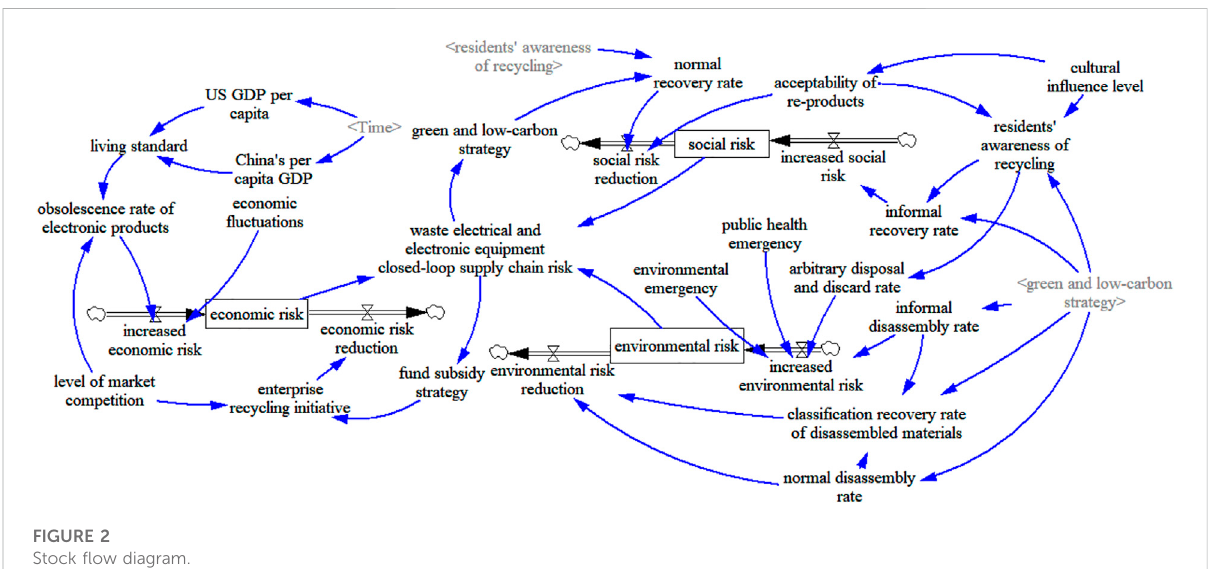
FIGURE 2 Stock fl ow